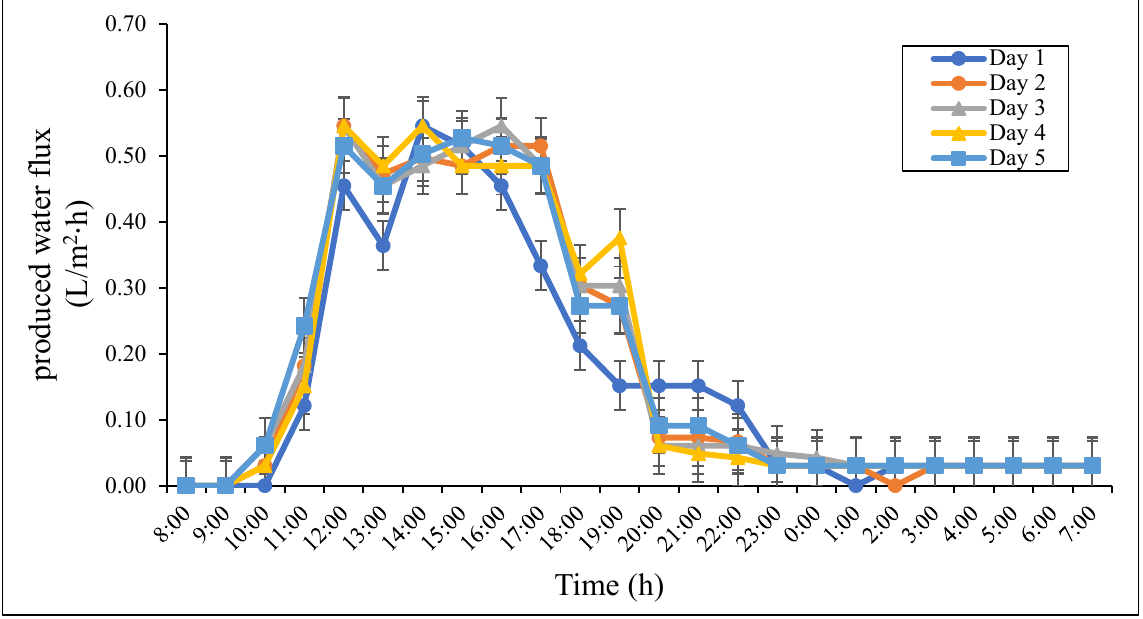
Figure 11. Effect of the flow continuity on the water production rate.